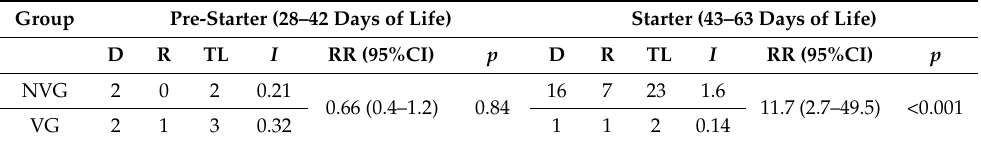
Table 3. Estimates of incidence rate ( I ; 1000 piglets-day at risk) for the non-vaccinated (NVG) and vaccinated (VG) groups for each period of nursery (pre-starter and starter) and corresponding relative risk (RR) between